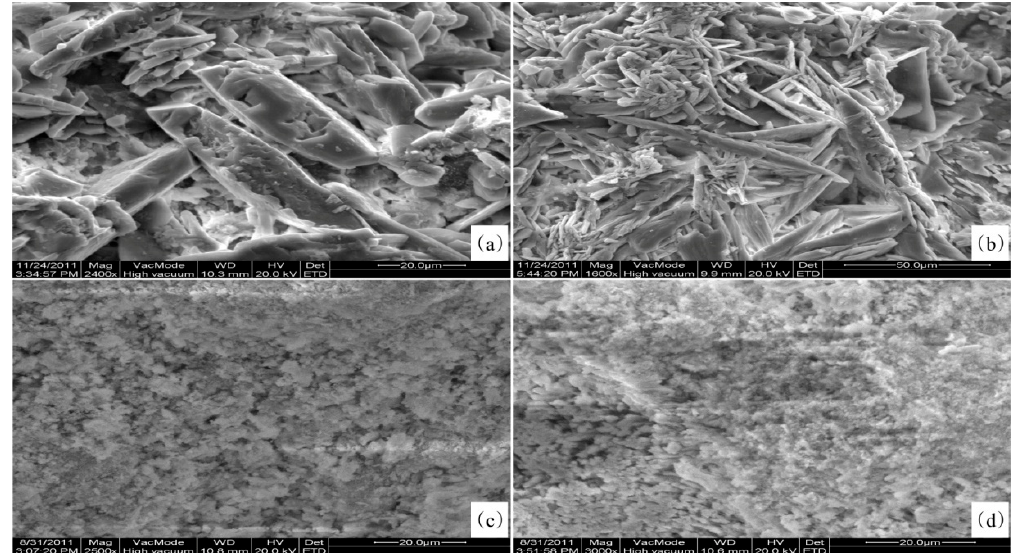
Figure 3. Crystalline morphology of precipitated salt in the multi-stage fans. ( a ). Columnar gypsum crystals in a multi-stage fan in the upper part of the windward slope of the megadune to the east of Zhalate Lake. ( b ). Needle-like gypsum crystals from the central part of the leeward slope of the megadune to the west of Yinderritu Lake. ( c ), ( d ). Calcite micro-crystals of in a multi-stage fan in the upper part of the windward slopes of the megadunes to the east of Zhalate Lake and to the west of Yinderitu Lake. Table 1. Chemical composition of precipitated salt samples obtained by energy spectrum analysis (%). Sites